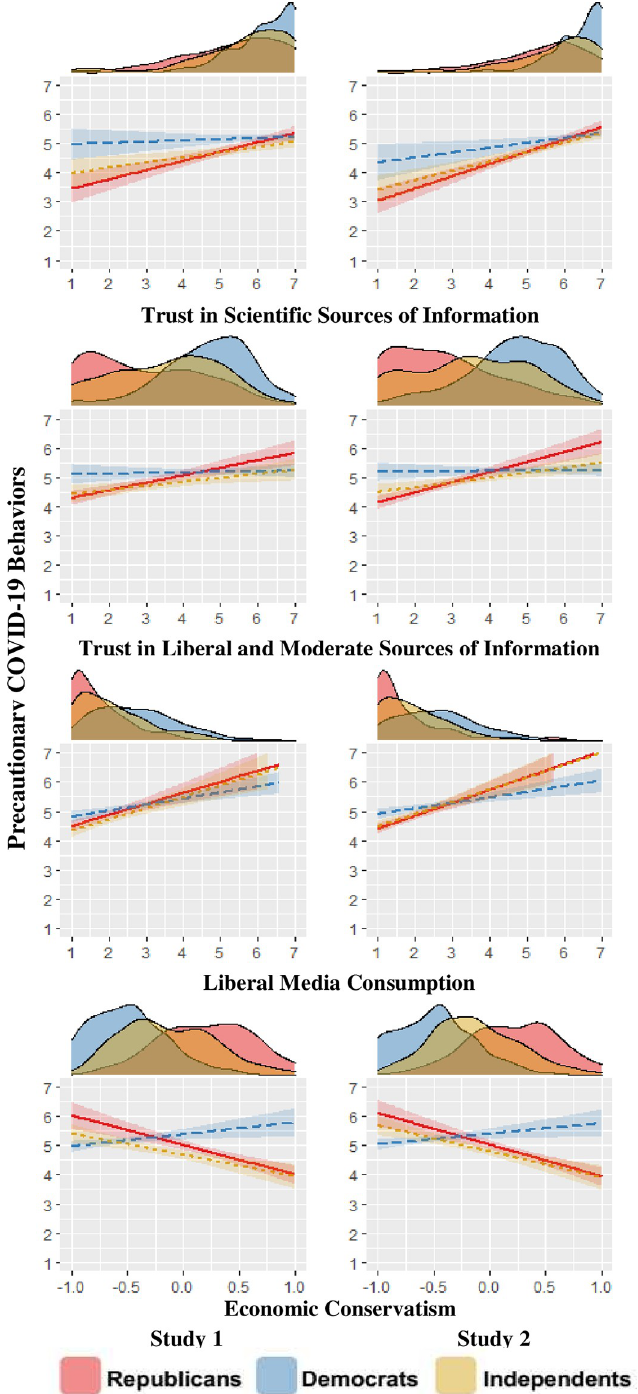
Fig 2. Relationships between suppressor variables and COVID-19 precautions. Studies 1 and 2 conditional effects of moderated linear regressions, in which COVID-19 precautions was regressed individually on each identified suppressor variable, political party affiliation, and the interaction between the suppressor and party affiliation. These (centered) suppressors were trust in scientists as information sources, trust in liberal and moderate figures as information sources, liberal media consumption, and economic conservatism. Bands around regression lines are 95% confidence intervals. The density plots along the x-axes represent the raw distributions of each suppressor variable by party